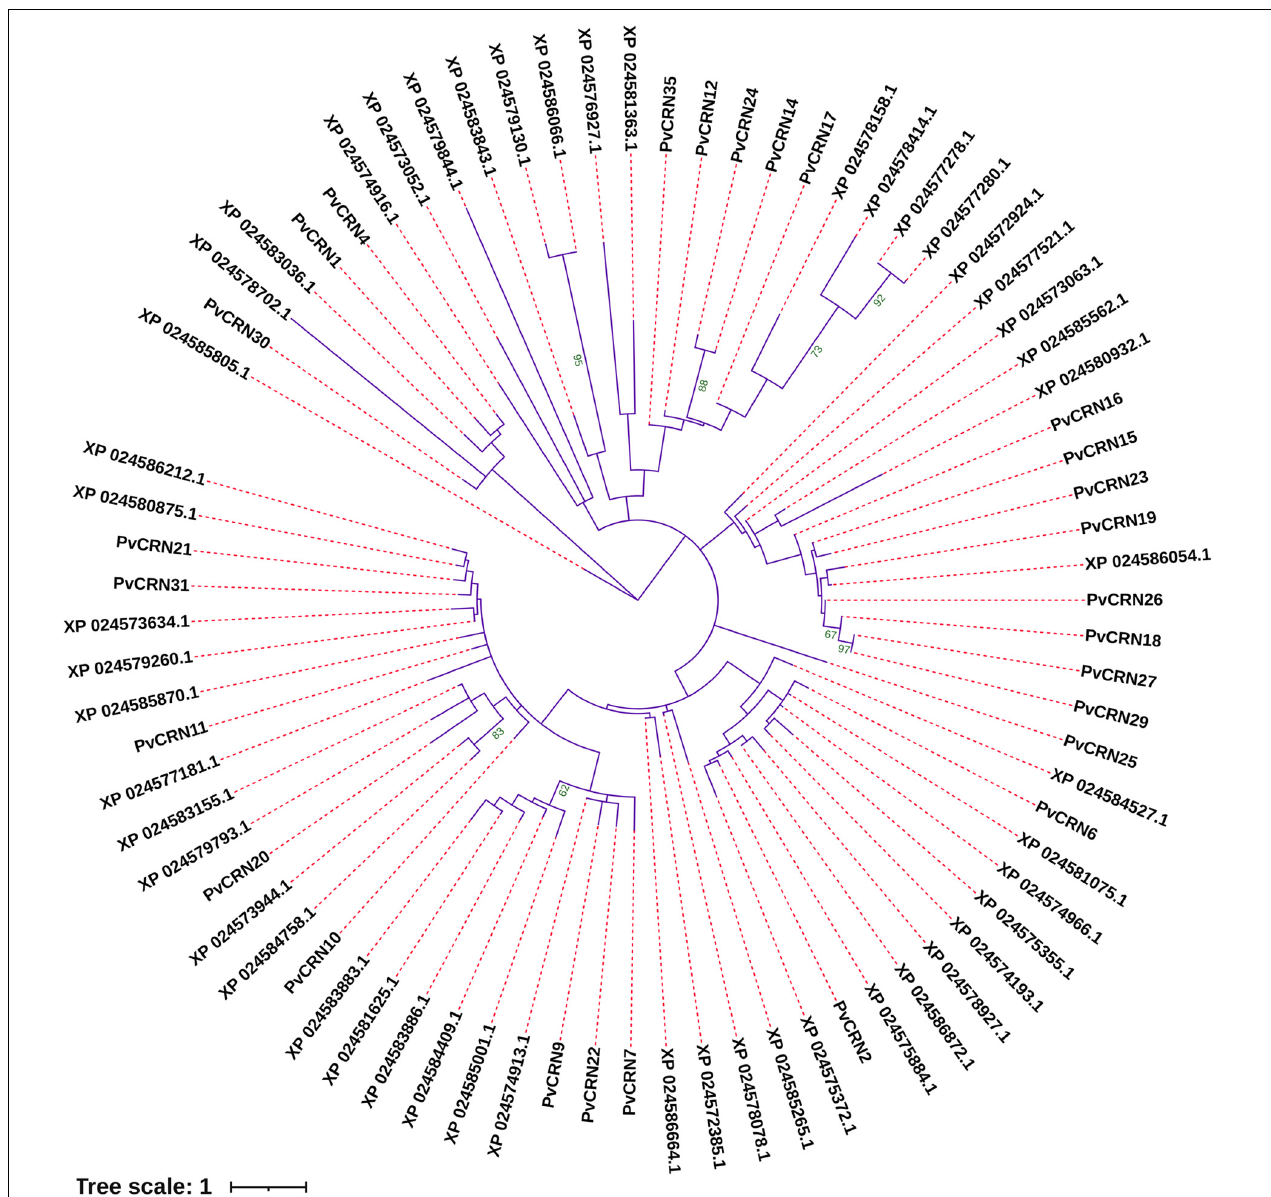
FIGURE 2 | Phylogenetic relationships among the CRN proteins from P. viticola YL and P. halstedii . The phylogenetic tree was generated in MEGA7.0 using the maximum likelihood method with 1,000 bootstrap replicates. The optimal substitution model was WAG + G. Bootstrap values greater than 50 are indicated in green on the